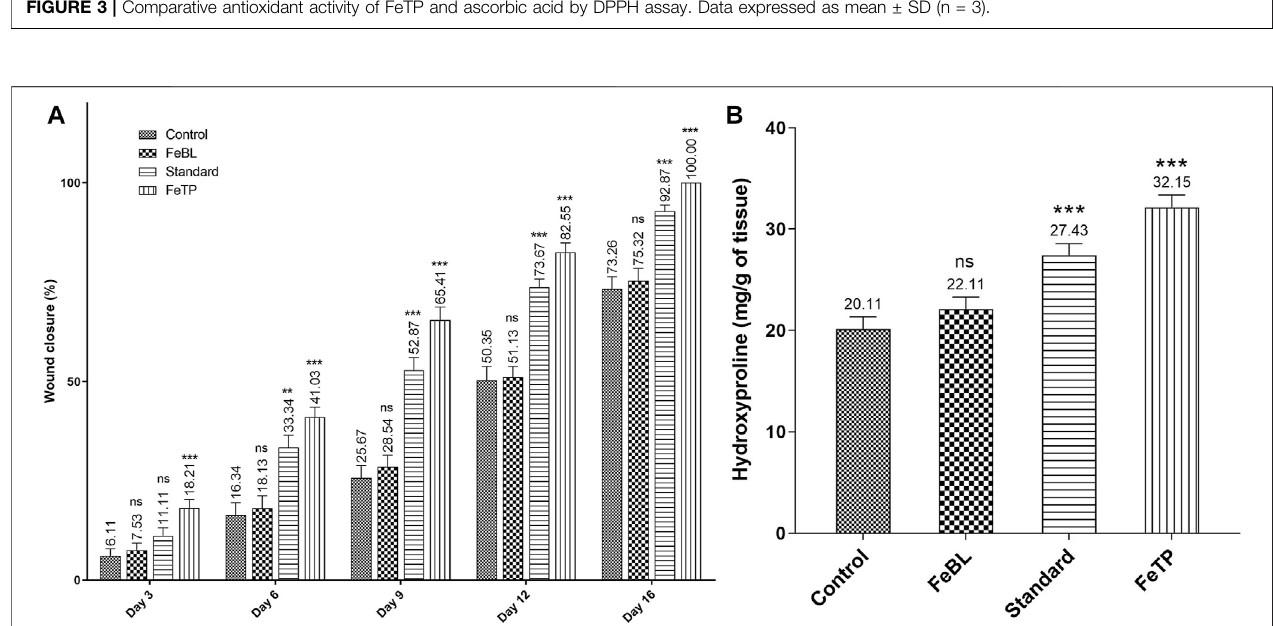
FIGURE 3 | Comparative antioxidant activity of FeTP and ascorbic acid by DPPH assay. Data expressed as mean ± SD (n (cid:2) 3).